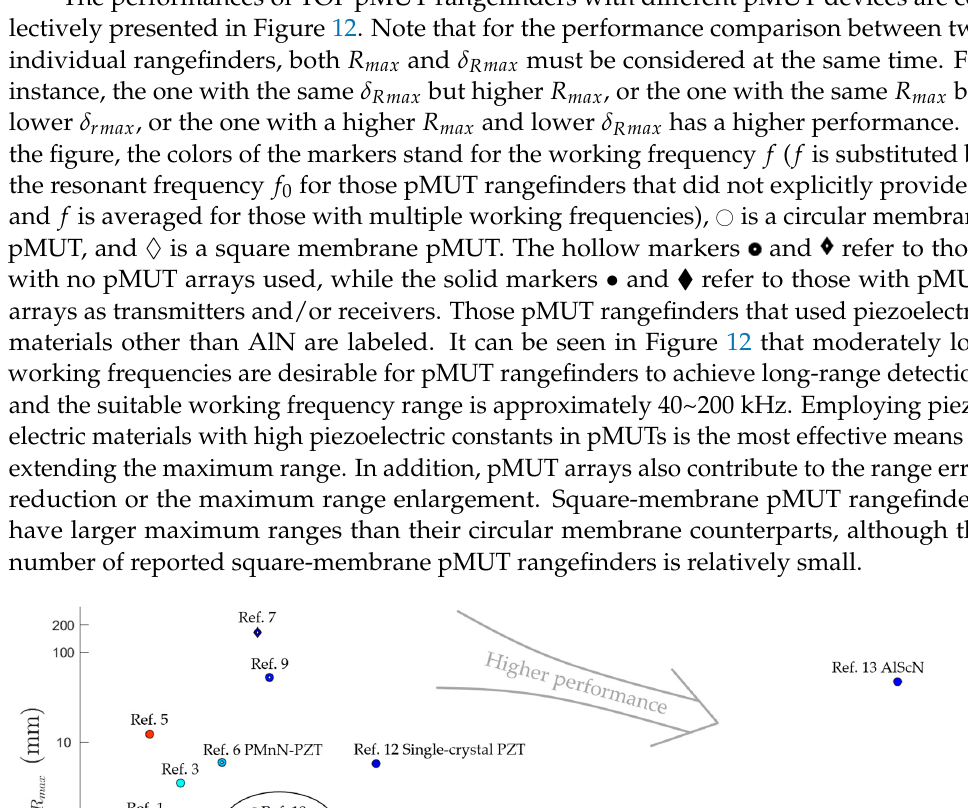
Table 6. Summary of pMUT rangefinders with different piezoelectric materials. Piezoelectric Material